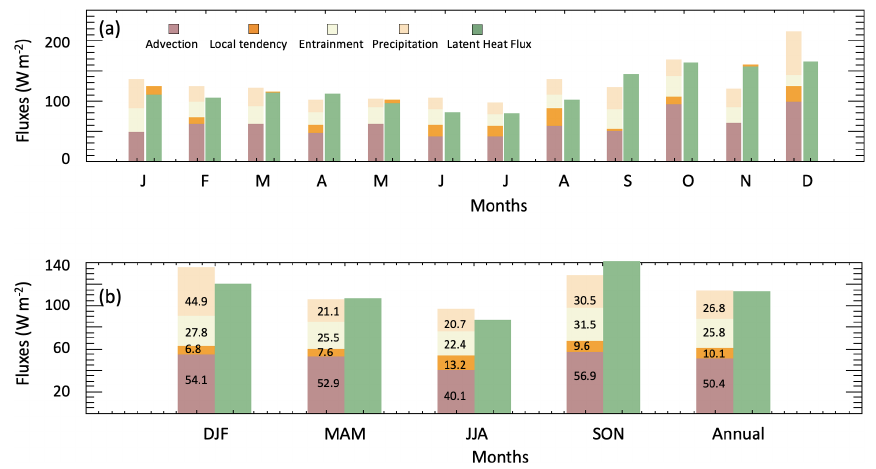
Figure 5. Monthly (a) and seasonal (b) components of the moisture budget. The left bars are moisture sinks, and the right bars are moisture sources. Color bars represent advection (brown), local tendency (orange), entrainment (cream), precipitation (pink), and latent heat fluxes (green). Numbers in the bottom plot are percent values. The residual terms are not shown in this figure. Table 2. Seasonal average values and standard deviation of the budget components. In parenthesis are the contributions of each negative term to the total boundary layer drying. Residuals are computed as the difference between source and sinks (Wm − 2 ).